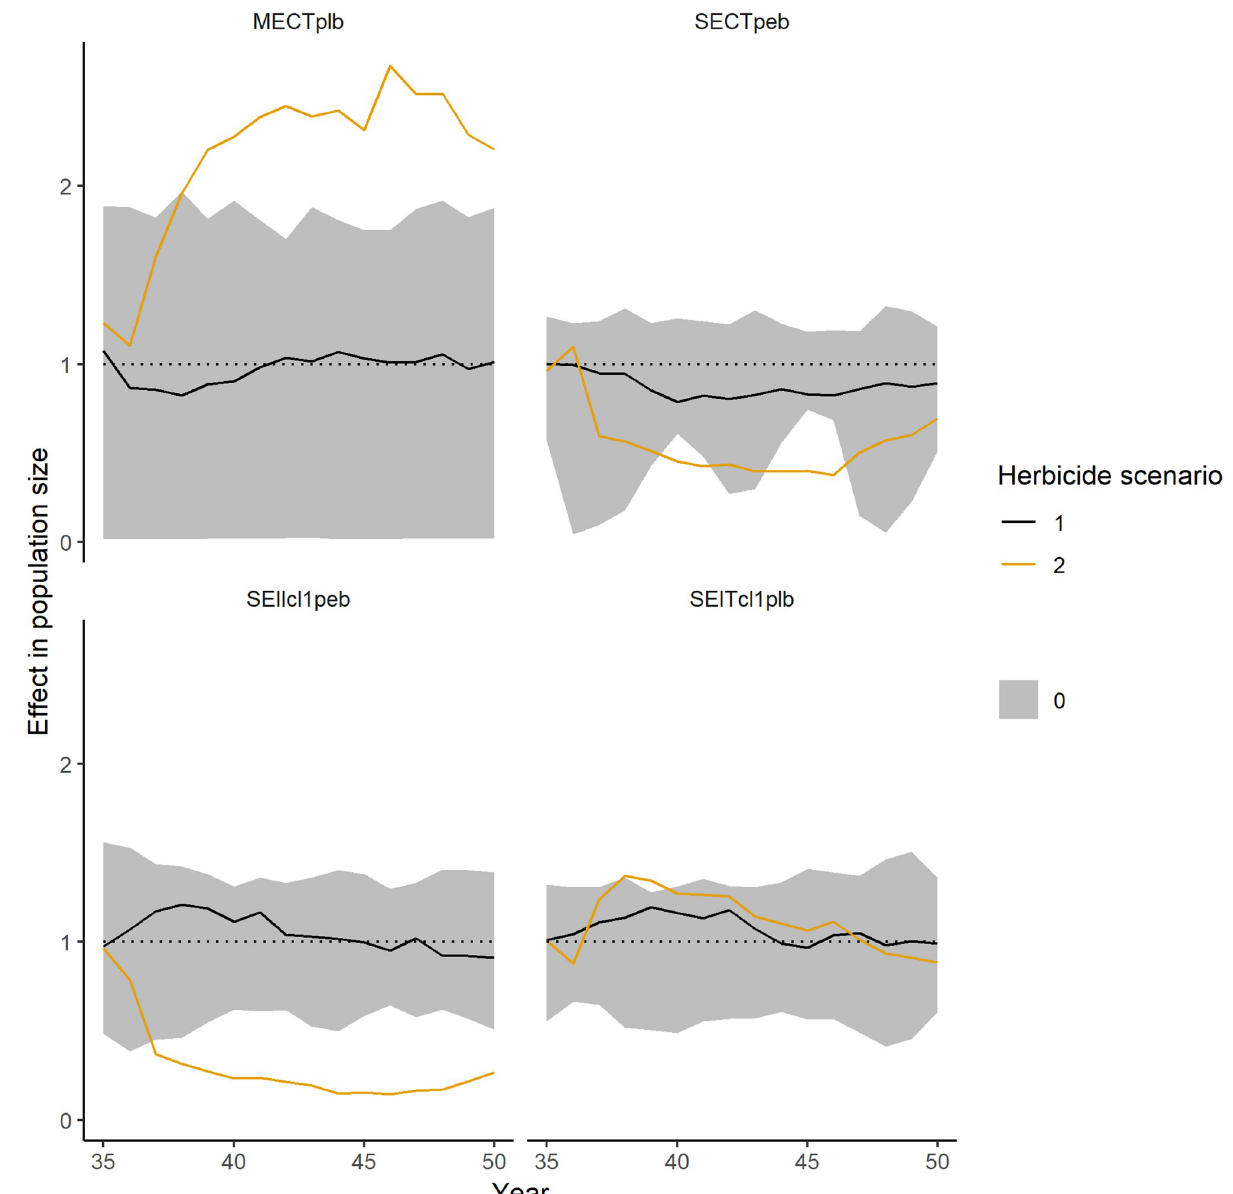
Fig 7. Long-term impacts on the population sizes of selected PFTs over the simulated period. Values below 1 represent a negative impact, values equal to 1 no impact and values above 1 a positive impact. Herbicide application starts in year 36 and ended in year 45. The theoretical herbicide had an impact on biomass and mortality. PFTs had random dose response curves. Grey ribbons show the fluctuations within control simulations (averaged for each year), the black lines show the mean (averaged for each year) of the 1.1 g a.i./ha application rate (herbicide scenario 1), the orange line the mean (averaged for each year) of the 3.3 g a.i./ha application rate (herbicide scenario 2).